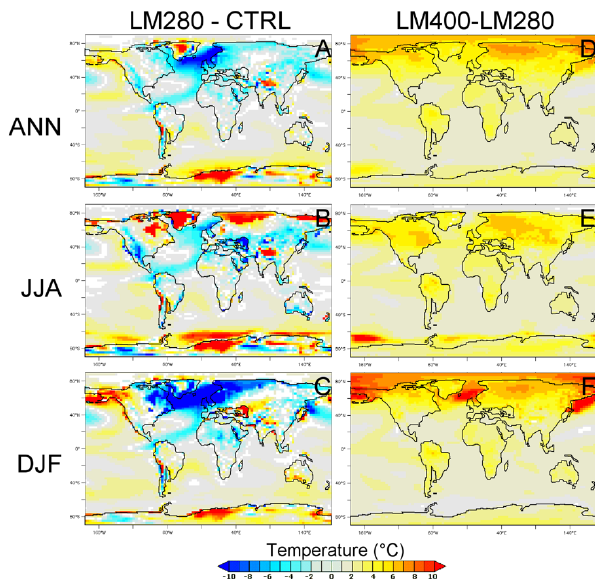
Fig. 4. Difference between the late Miocene and preindustrial sim- ulations (LM280-CTRL, left side) and between the late Miocene CO 2 simulations (LM400-LM280, right side) for mean air tempera- ture. Only significant differences are shown using a 95% confidence interval Student’s t -test; white areas are not